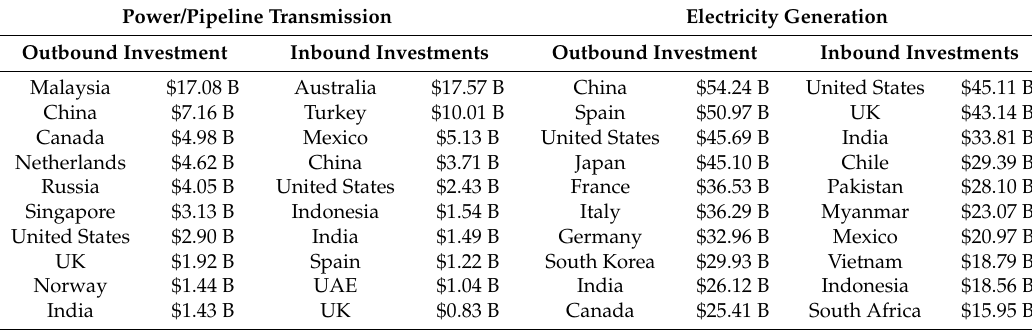
Table 3. GF FDI across energy supply chain sectors; top ten countries,